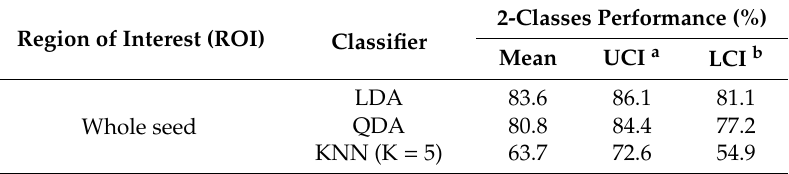
Table 3. Conventional machine learning performance.